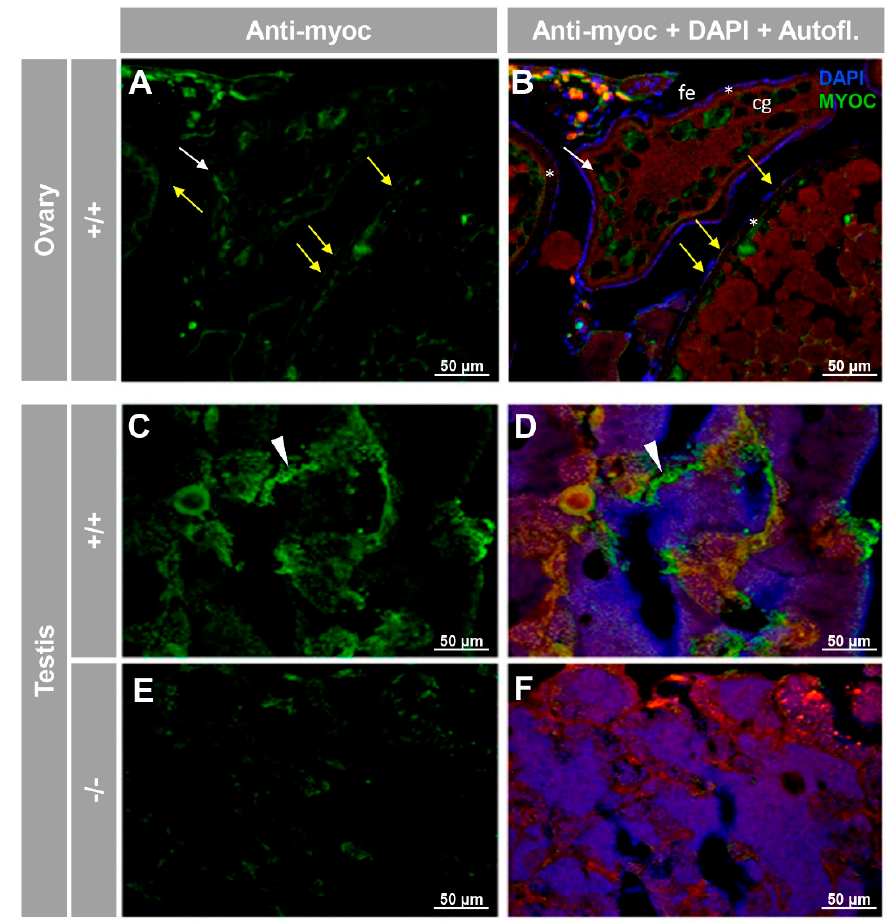
Figure 7. Immunohistochemical detection of myoc in the reproductive system of adult zebrafish. Tissue sections (14 μ m) of adult (7 months) wild-type ovary ( A , B ) and testis ( C , D ) and KO myoc testis ( E , F ) were incubated with an anti-myocilin (TNT) primary antibody, followed by Cy2-conjugate goat anti-chicken IgY secondary antibody (green signals). Note that ovaries from -/- animals were not available because of the absence of females with this genotype. White and yellow arrows indicate cortical granules and follicular epithelium-associated immunoreactivity, respectively. White arrowheads show immunolabeling in the seminiferous epithelium ( C , D ). Red signals corre- spond to tissue autofluorescence. The images are representative of the result observed in three tissue sections from three animals. +/+: wild-type; -/-: myoc KO. cg: cortical granules. fe: follicular epithelium. *: zona radiata. Negative controls are shown in Figure S6.